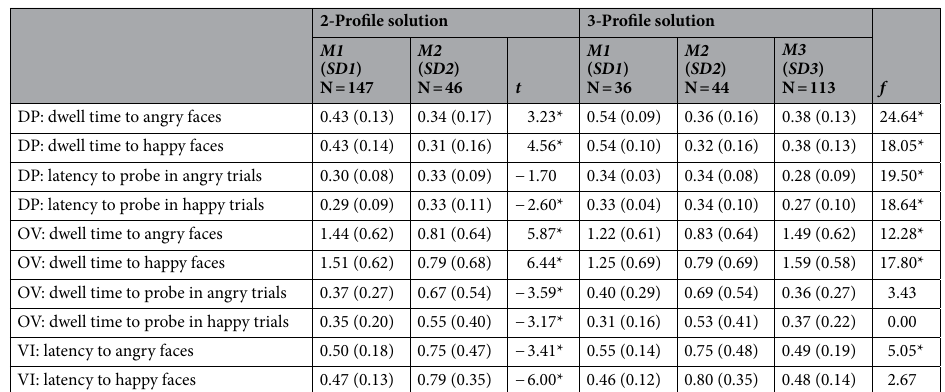
Table 2. 2- and 3-Profile solutions for LPA assessing affect-biased attention group membership. N = 193; * p < .05. DP dot-probe task, OV overlap task, VI vigilance task, M mean, SD standard